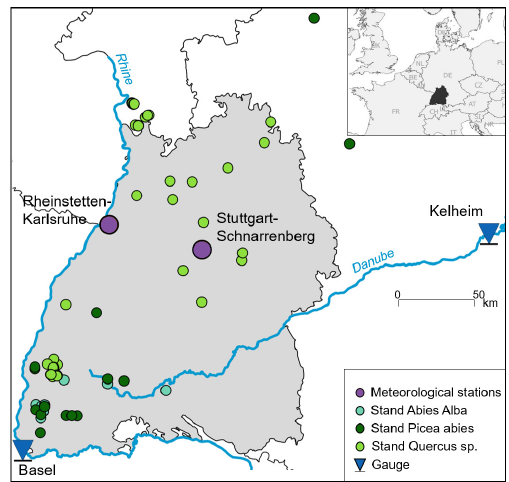
Figure 2. Baden-Württemberg and locations (“stand” signifies lo- cation of forest stands) of various data sources considered in the